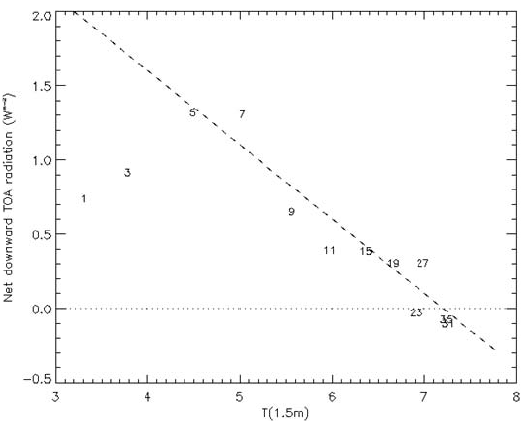
Fig. 7. Anomalous net top-of-atmosphere downward flux in LEP2 vs surface temperature change during the transient-warming phase of the integration. (Each value has had the time-mean value for that quantity in run LEP1 subtracted from it.) The numbers identify the years into the integration. Years 1–10 have biannual means plotted, while years 10–35 have quadrennial means plotted. The dashed line corresponds to the linear regression TOA=3.6–0.5T and the slope represents the feedback parameter.